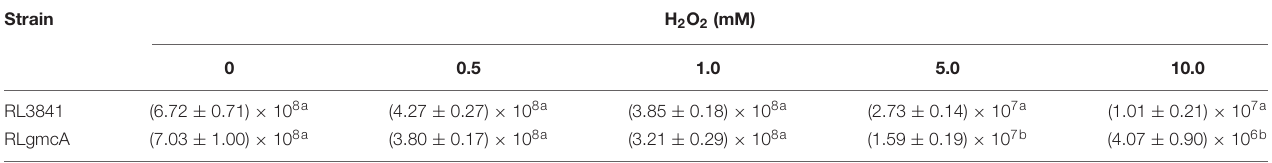
TABLE 2 | Tolerance of R. leguminosarum stains to different concentrations of H 2 O 2 .